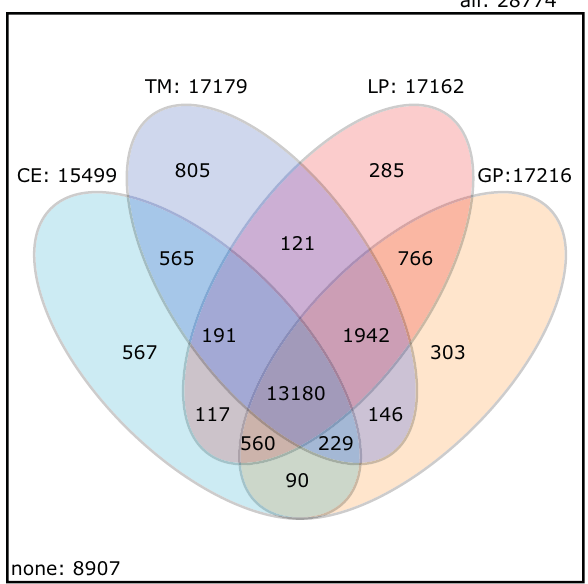
Figure 2. Impact of Different Similarity Measures on Inferring Function. The four-set Venn diagram covers the correct GO term inferred from the neighbors based on the individual similarity measures. Each ellipse represents the number of GO terms correctly inferred using one similarity measure. The numbers of GO terms correctly inferred by several similarity measures are shown in the intersections between one or more ellipses.